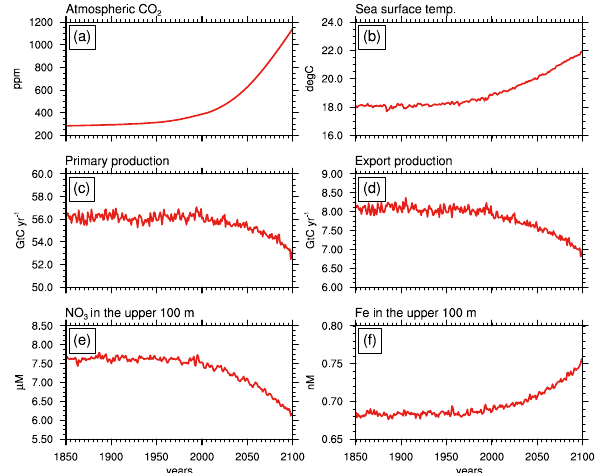
Fig. 1. Temporal variations of simulated globally averaged annual mean atmospheric CO 2 (ppm) (a) , sea surface temperature ( ◦ C) (b) , globally integrated annual mean primary production (GtCyr − 1 ) (c) , export production (GtCyr − 1 ) (d) , and surface NO 3 (µM) (e) and surface Fe (nM) (f) averaged over the upper